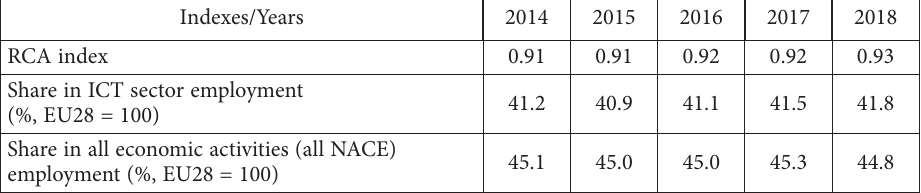
Table 2. RCA index for the group of NUTS2 regions with SS in ICT and their share in the UE28 economy and the ICT sector (2014–2018) (source: authors)